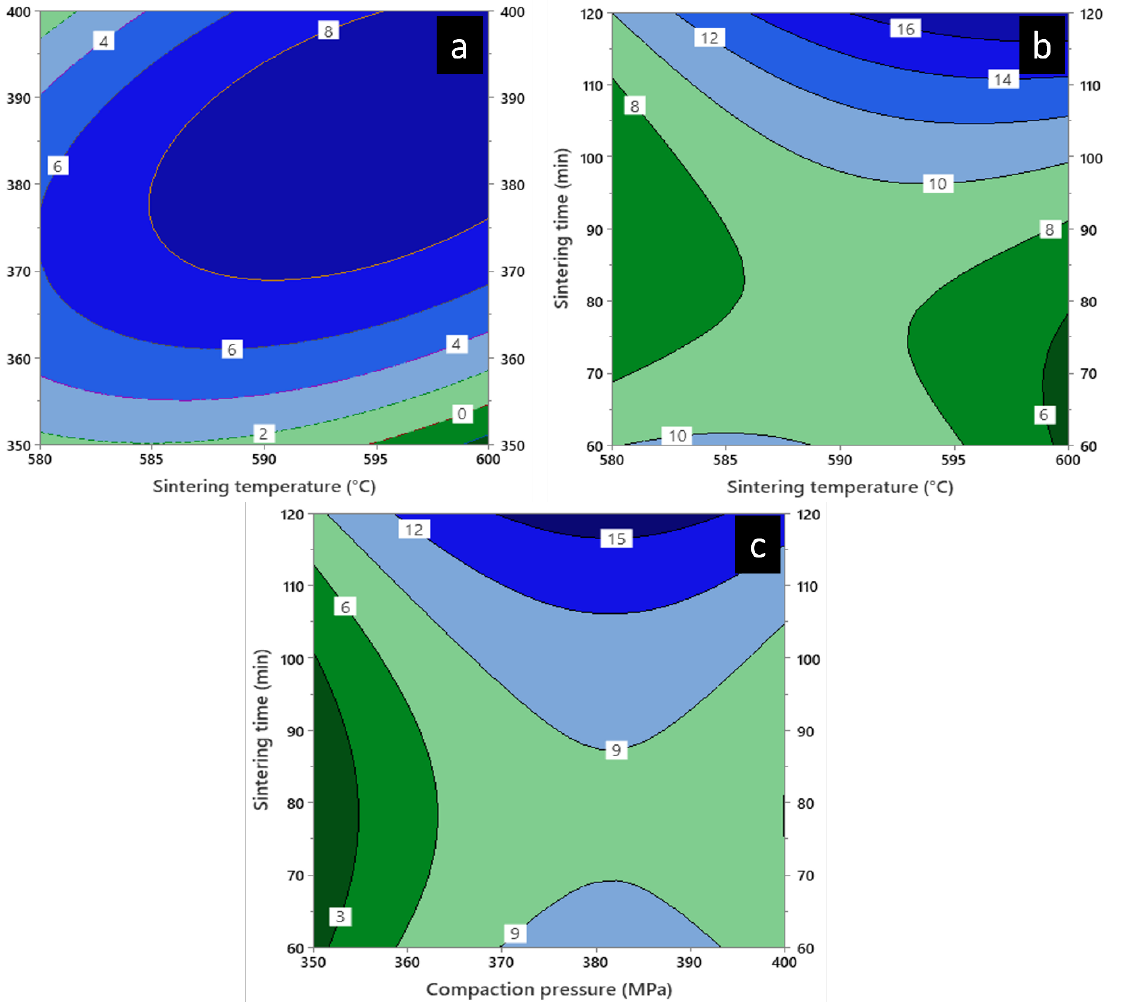
Figure 13. Contour plot of plateau stress in diamond-reinforced porous Al composites showing, ( a ) Compaction pressure vs sintering temperature, ( b ) Sintering time vs sintering temperature and ( c ) Sintering time vs compaction pressure.